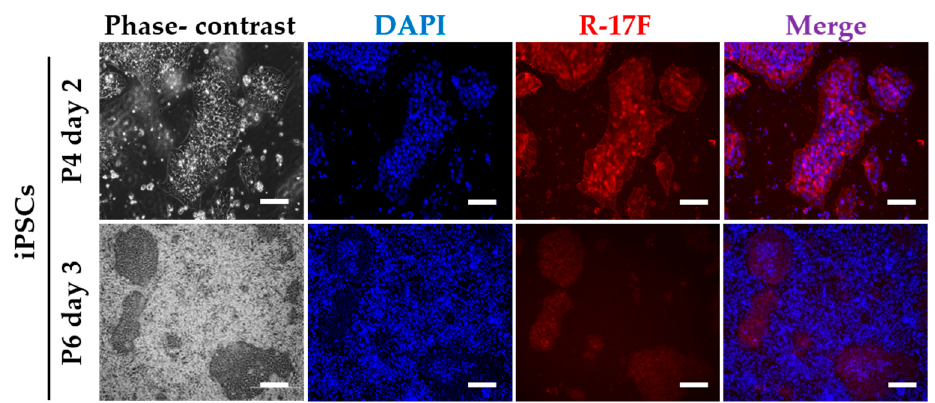
Figure 3. Evaluation of the ability of the R-17F antibody to bind iPSCs. Cultured iPS cell lines 606A1 (P4, day2) and 201B7 (P6, day3) were incubated with R-17F (10 µg/mL), followed by stained with 4’,6-diamidino-2-phenylindole (DAPI, Blue) and incubation with secondary antibody (Alexa Fluor 594-conjugated goat anti-mouse IgG antibody, Red). Scale bar = 500 µm.